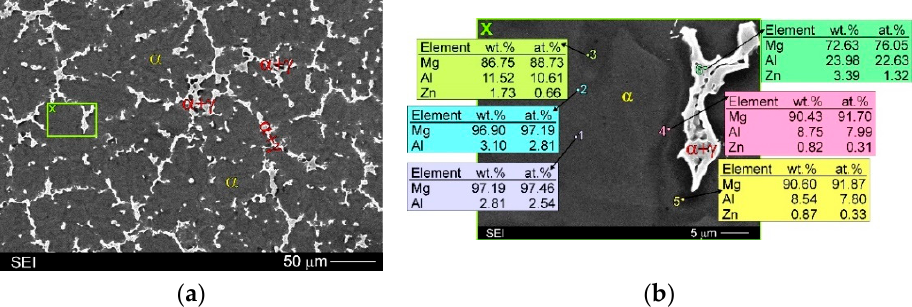
Figure 4. Microstructure of unreinforced AZ91 matrix alloy: ( a ) SEM micrograph; ( b ) Higher magnification of area marked as X on ( a ) micrograph with EDX results obtained from designated points.